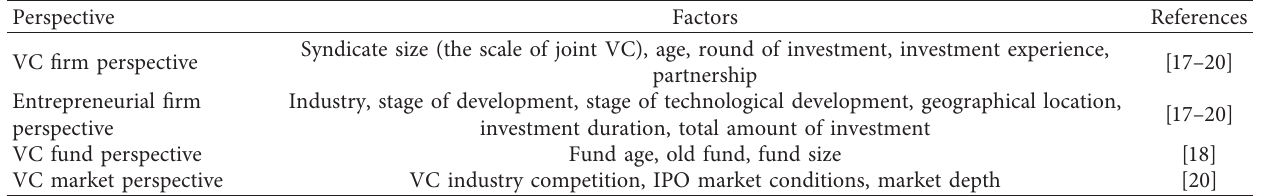
Table 1: The determinants of VC’s successful